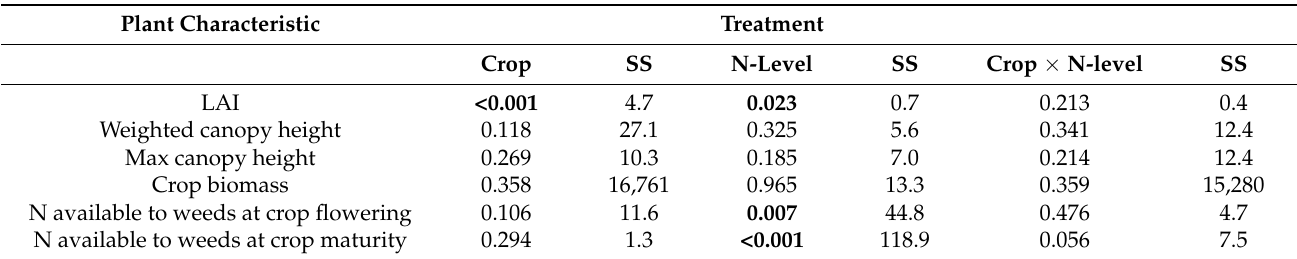
Table 2. Effect of crops, N-levels, and their interaction on crop traits, N availability to weeds and N accumulation from different sources, assessed in original plots (leaf area index LAI (m 2 m − 2 ), weighted and max canopy height (cm)) and 15 N micro-plots (crop biomass (g m − 2 ) and N available to weeds (g m − 2 )) at crop flowering and maturity. Numbers are p -values following analysis of variance as well as the sums of squares (SS). p -values smaller 0.05 are marked in bold. n =